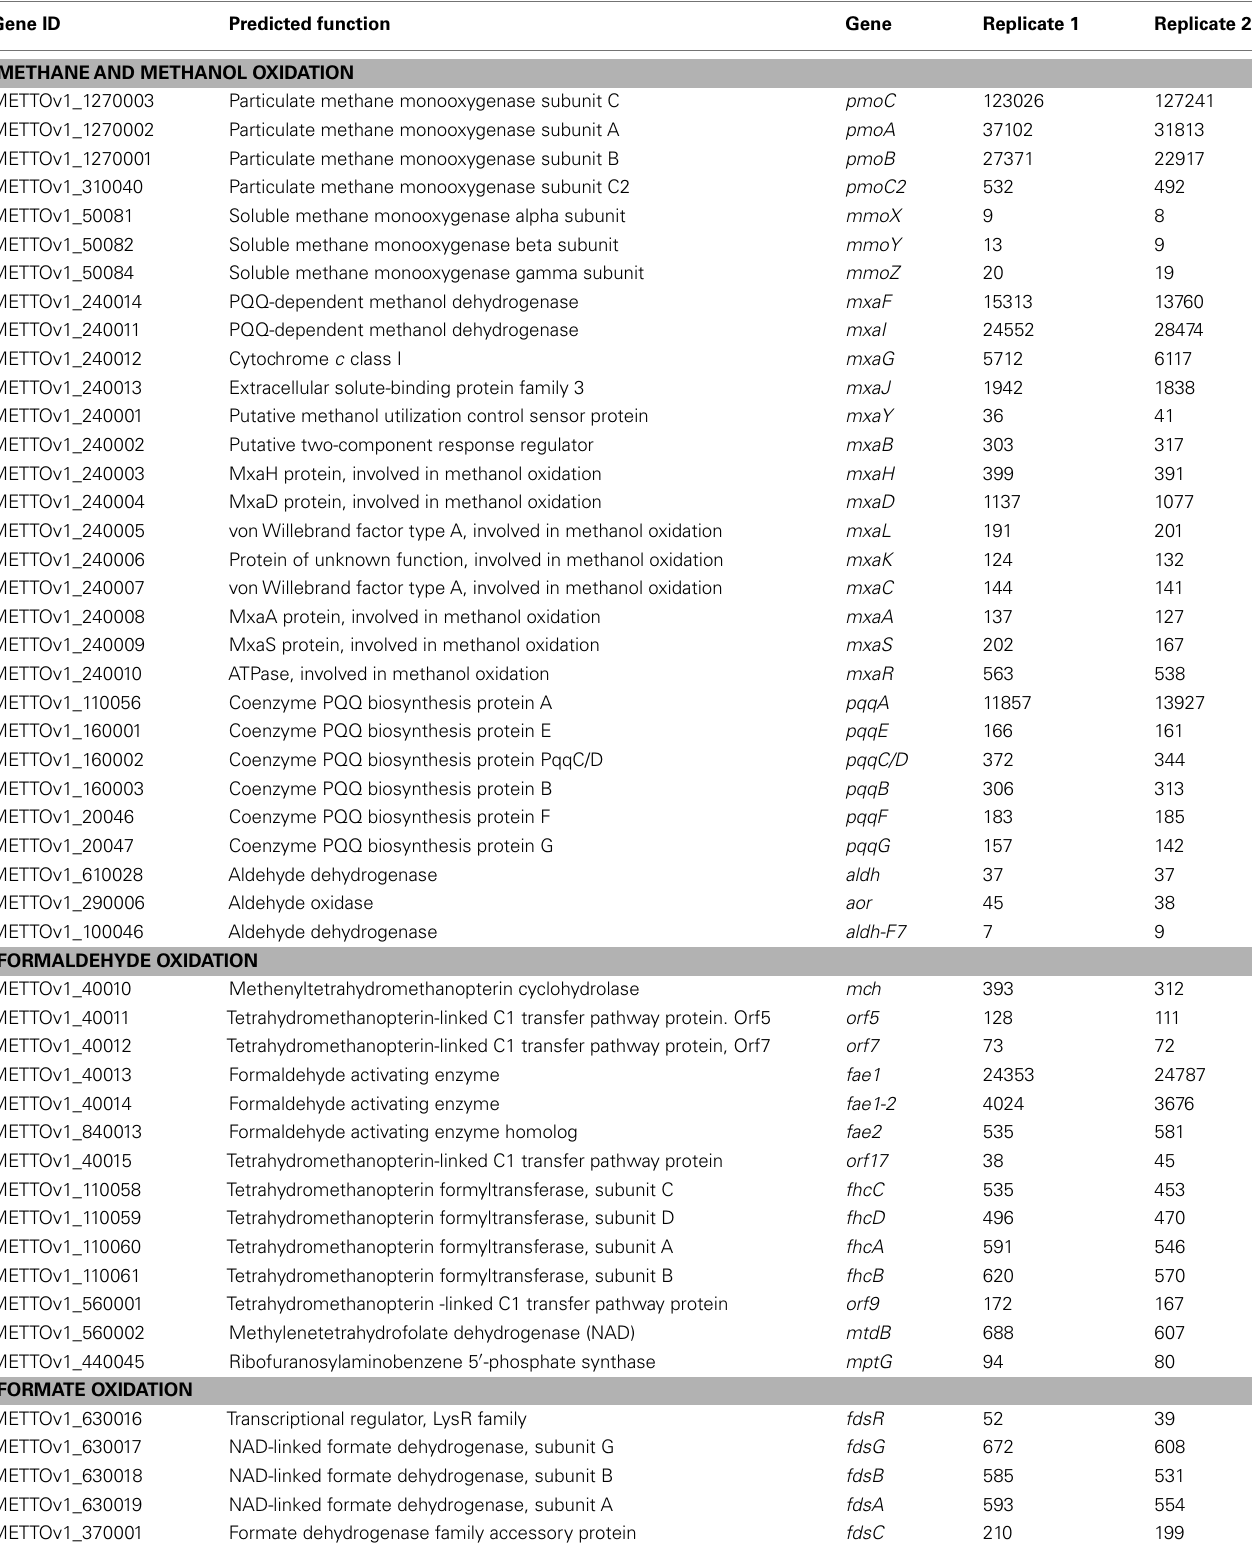
Table 2 | Gene expression profile in methane-grown cells of M. trichosporium